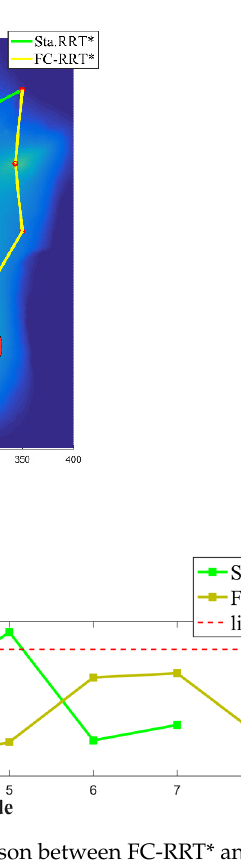
Figure 9. Path comparison of RRT* and FC-RRT* in 3D view.